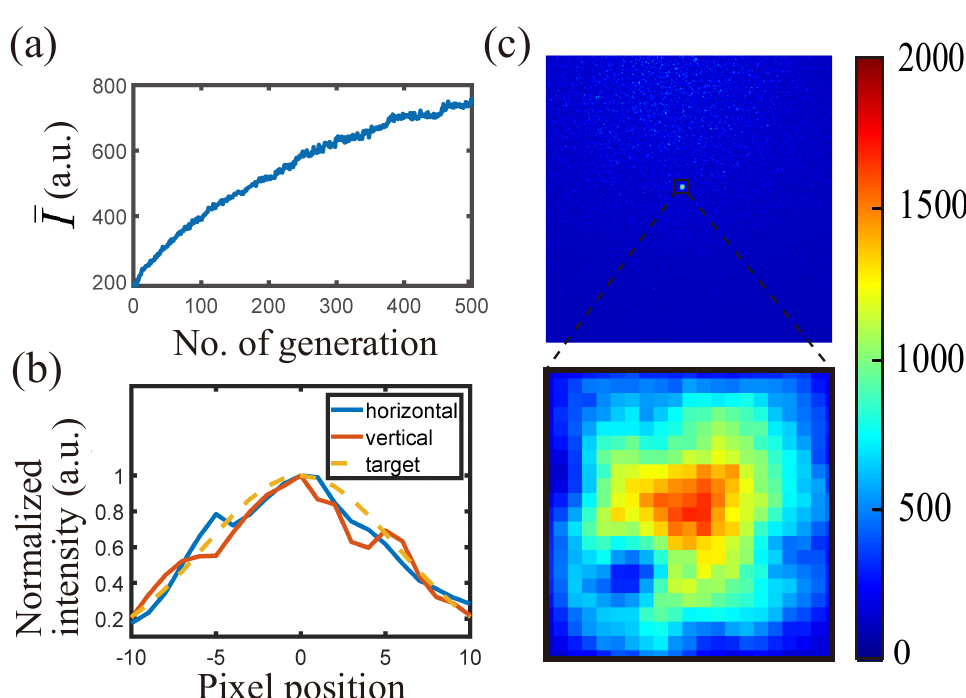
Figure 8. Intensity distribution controlled using SBGA with two discriminants ( f 1 , f (cid:48) intensity of the 20 × 20 pixels area over 500 generations. ( b ) Normalized optimal intensity along the horizontal and vertical lines across the center. The desired target intensity distribution is shown by the yellow dashed line. ( c ) Optimal speckle image.